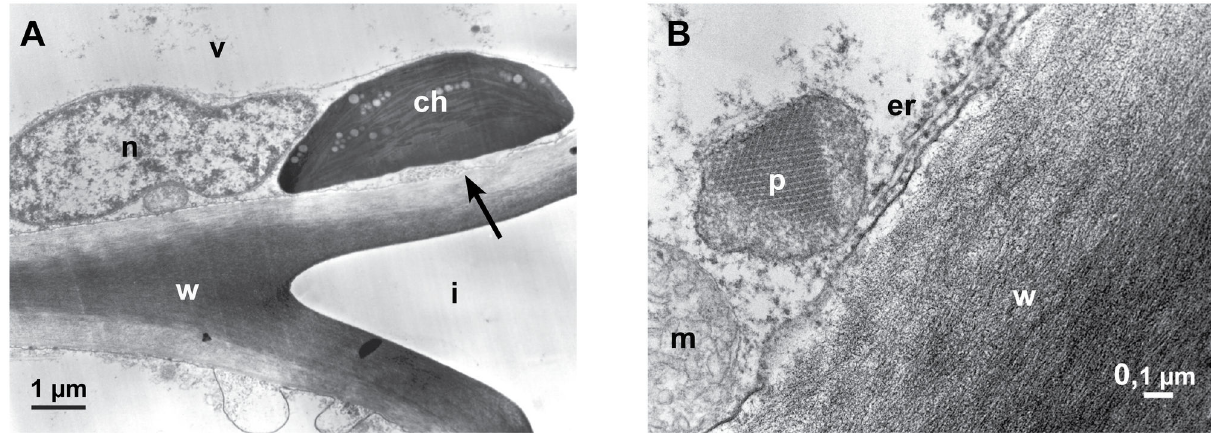
Figure 6. Reaction of the host cells. Transmission electron micrographs (12-24 hpi). A : A chloroplast (ch) changing contrast, the matrix appear electron dense. The brightening of the inner cell wall layer is probably the beginning of the degradation of the cell wall (arrow), nucleus (n), vacuole (v), intercellular space (i) and cell wall (w). B : A cortical parenchyma cell with peroxisome (p) containing protein-crystal (probably catalase), mitochondrium (m), endoplasmic reticulum (er) and cell wall (w). doi: